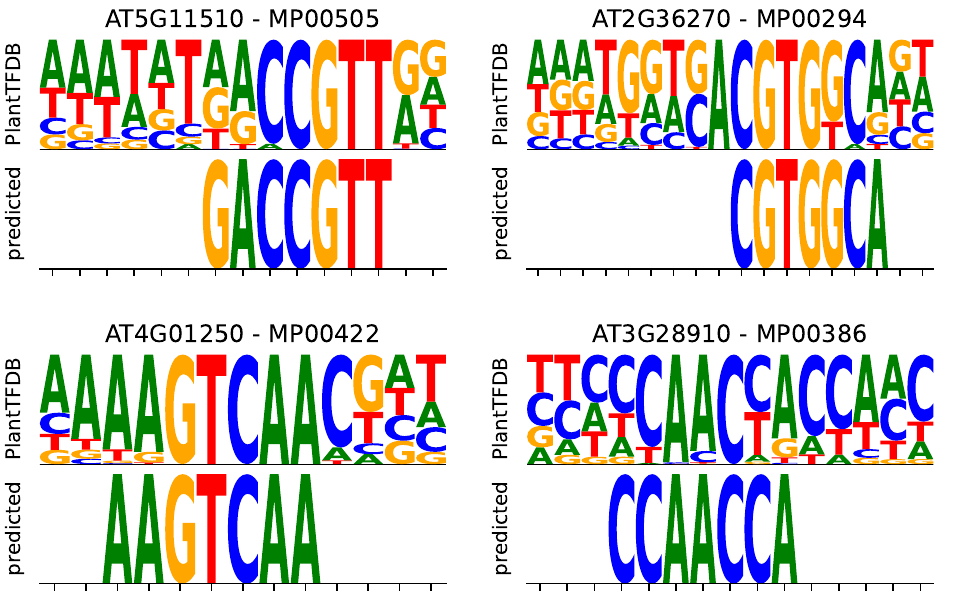
Figure 9. TRN-predicted motifs aligned to their best matching position in the respective PWM from the reference database. Top-scoring motifs are